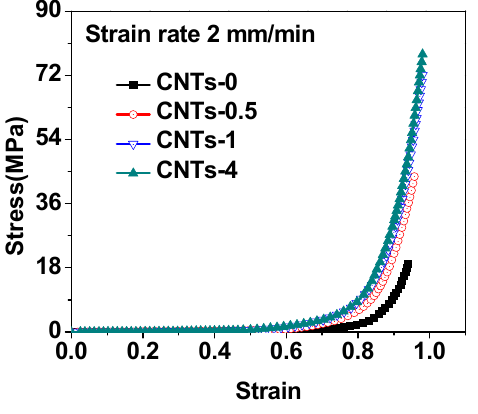
Figure 2. Compressive stress-strain curves for nanocomposite DN hydrogels.